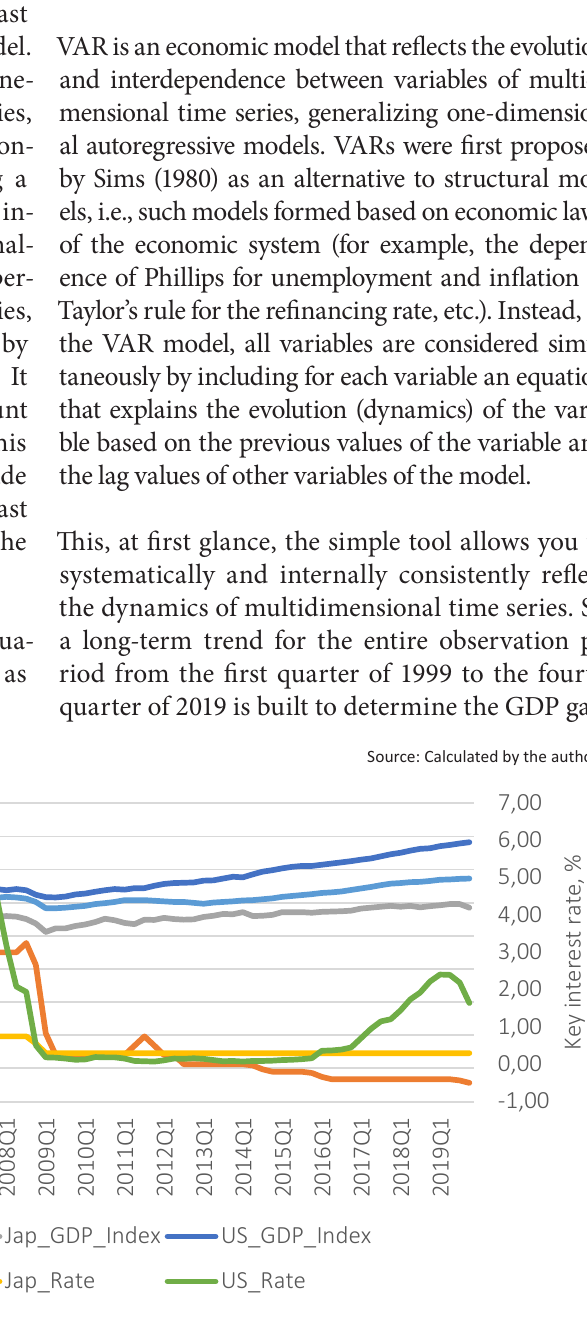
Figure 1. Dynamics of GDP indices and key interest rates of the considered